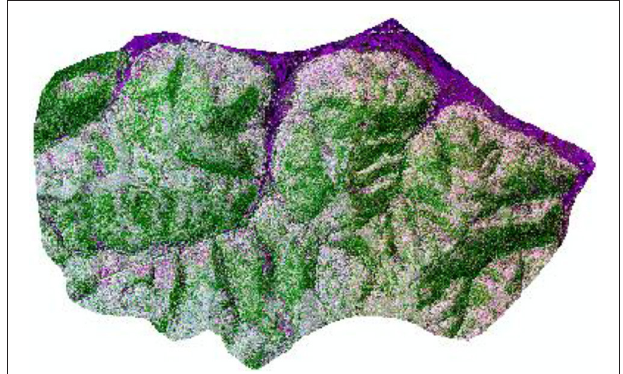
FIGURE 1 | The remote sensing image of study area under the merging methods of principal component